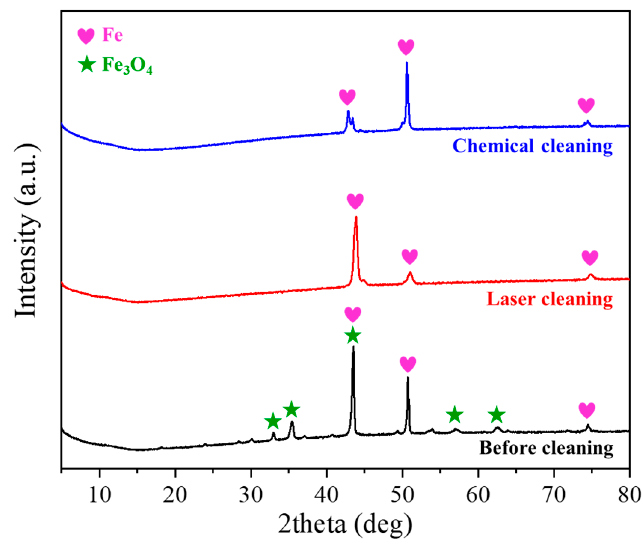
Figure 12. XRD analysis results of prototype before and after cleaning.